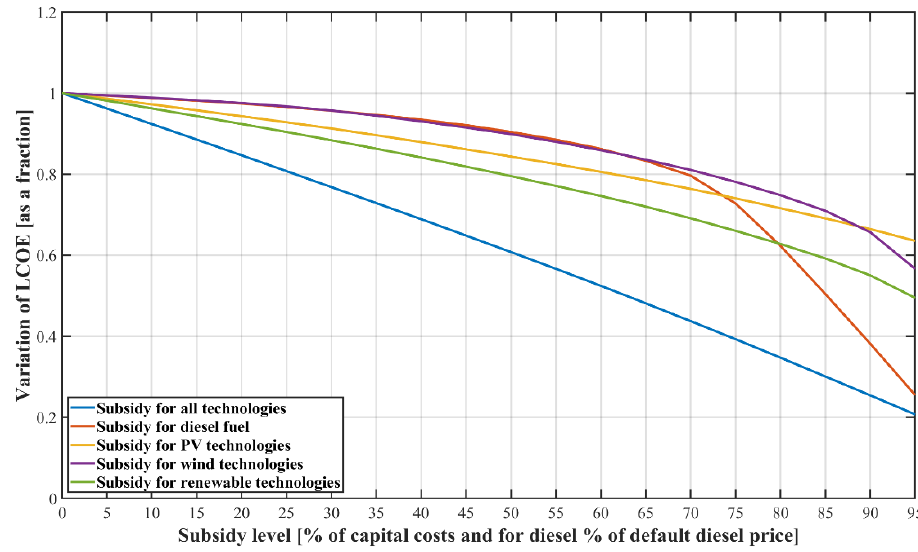
Figure 20. Impact of various policy instruments on the levelized cost of electricity.